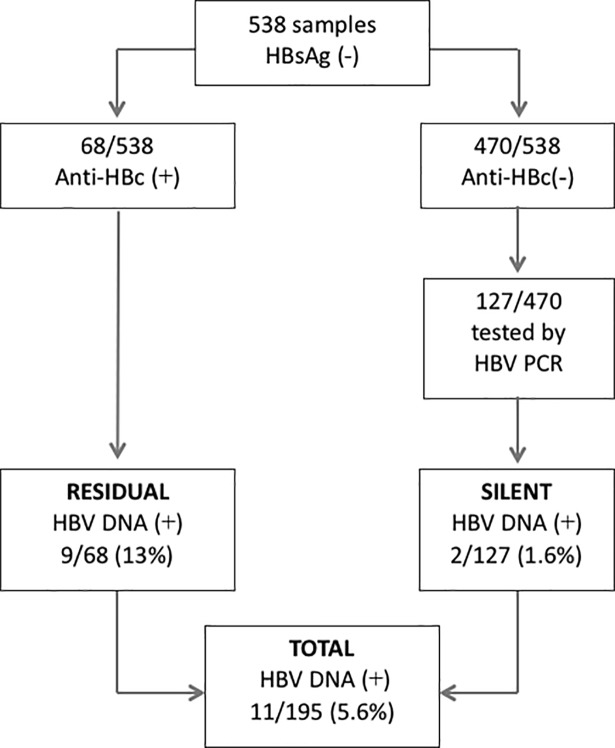
Occult hepatitis B Infection (OBI) prevalence in Warao Amerindians.Positive and negative samples are represented with + o–symbol respectively.